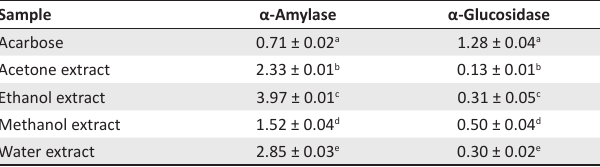
FIGURE 6: Inhibitory potential of Acalypha godseffiana leaf extracts against α-glucosidase activity. Key: Values are expressed as means ± SEM of triplicate determinations. Bars not sharing a common letter at the same concentration are significantly different ( p < 0.05). AA, acalypha acetone; AE, acalypha ethanol; AM, acalypha methanol; AW, acalypha water. values of α-amylase and α-glucosidase inhibition by Acalypha 50 godseffiana (leaves) extracts.